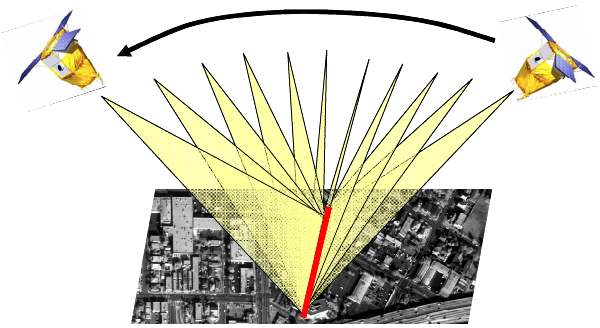
Figure 9 : slow-motion acquisition principle